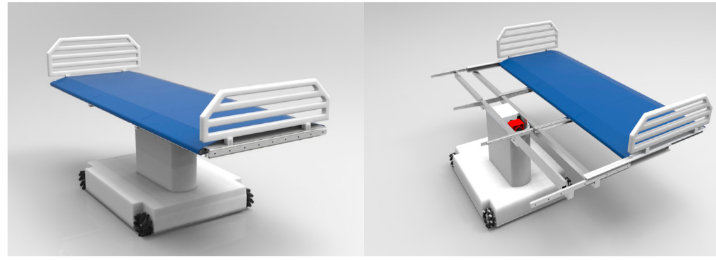
Figure 10. 3D rendering of the complete solution.